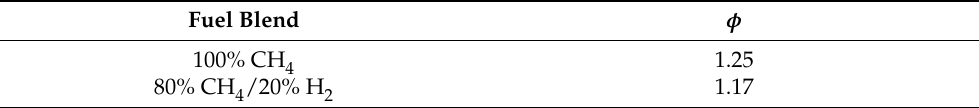
Table 2. Estimated equivalence ratio for appliance operation with different fuel